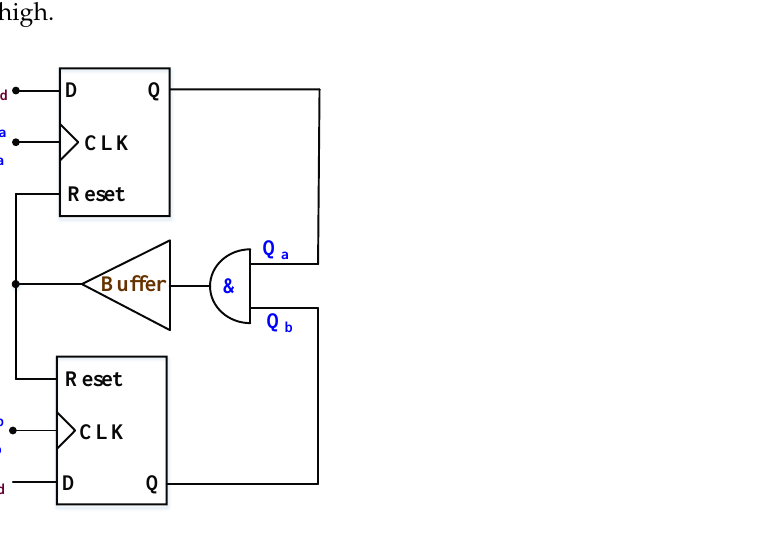
Figure 13. Adopted PFD with two DFFs, a buffer, and an AND gate.